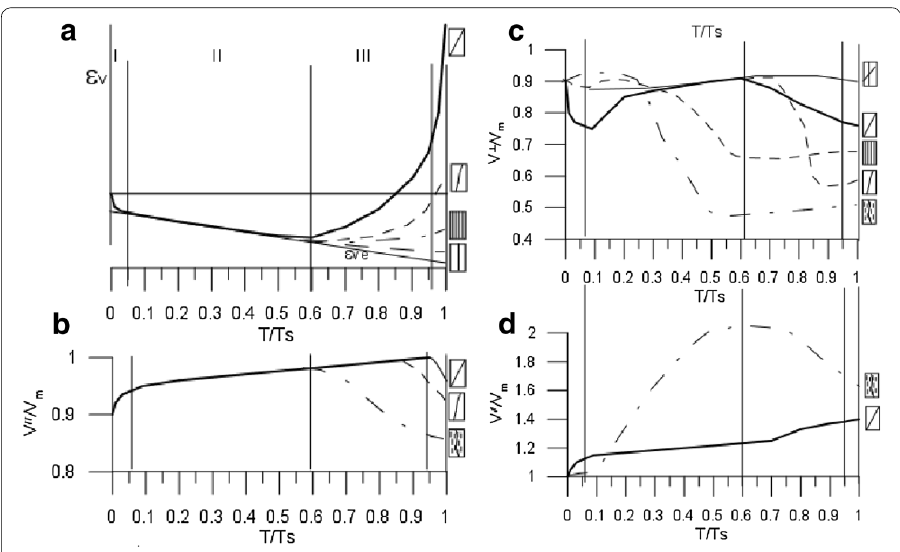
Fig. 7 Generalized behavior of the deformations and velocities during the sample loading (pictures are the sample macrofracture mode). a characteristic deformation stages; b variation with stress level of V ″ /V ″ m (rela- tive axial velocity spreading along the normal maximum stress σ 1 ; c variation with stress level of V ┴ /V ┴ m (e.g. relative axial velocity spreading along the normal minimum stress σ 3 ; d variation with stress level of V ┴ /V ″ . Pictures in right of graphs shows mode of sample